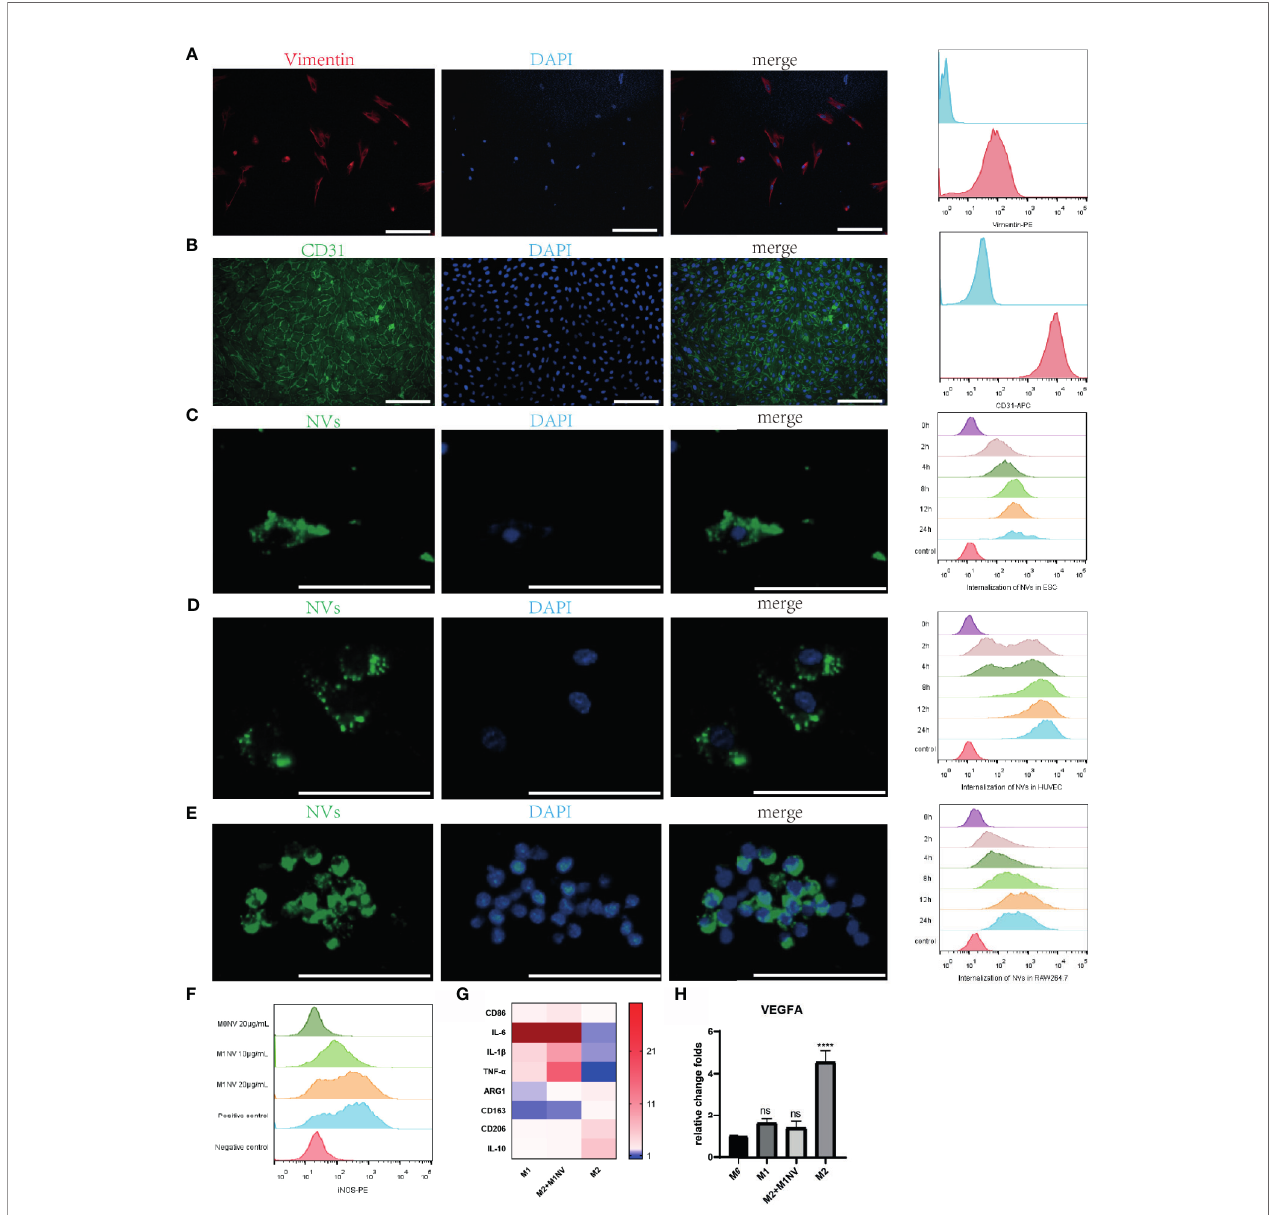
FIGURE 2 | M1NVs were internalized by primary cells and macrophages and reprogrammed M2 into M1 macrophages. (A) ESCs derived from endometrium expressed stroma marker Vimentin (Scale bar = 100 m m). (B) HUVECs derived from normal human umbilical veins expressed CD31, the endothelial marker (Scale bar = 100 m m). (C – E) NVs labeled by PKH67 were internalized in the ESCs, HUVECs and macrophages. With the passage of time, the number of NVs internalized into the cells was increasing (Scale bar = 100 m m). (F) M2 macrophages were polarized into M1 by M1NVs, and 20 m g/mL of M1NVs were suf fi cient to play the role. (G) RT-qPCR revealed the up-regulated M1 markers ( CD86 , IL6 , IL1B, and TNFA ) and down-regulated M2 markers ( ARG1 , CD163 , CD206 , IL10 ) in Re-M2 macrophages. (H) Re-M2 macrophages expressed lower level VEGFA than M2 macrophages. ns, no signi fi cance when compared to M0. ****P<0.0001 when compared to